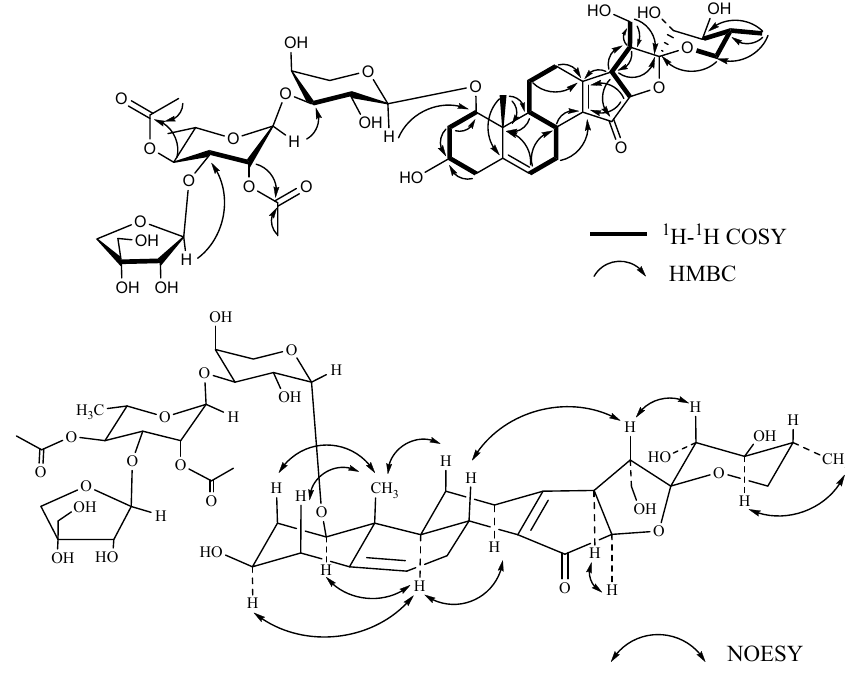
Figure 4. Key 1 H- 1 H COSY, HMBC, and NOESY correlations of compound 3 . Compound 4 , named Pamaiosides D, a white amorphous solid, was positive to Liebermann Burchard and Molisch chemical reactions. The pseudomolecular ion peak was measured in the HR-ESI-MS spectrum at m/z 993.3969 [M + Na] + (calculated for C 46 H 66 O 22 Na, 993.3943), corresponding to the molecular formula C 46 H 66 O 22 . Compared with 3 , only two distinctions, the position of one acetyl group and the sugar linkages, were detected (Tables 1–4). The acetyl group replaced at C-21, which was evidenced by the al- tered proton chemical shifts at δ H 3.46 (H-4 of Rha, ∆ δ C -1.49 ppm), δ Ha 4.19 (Ha-21, ∆ δ C + 0.45 ppm), and δ Hb 4.33 (Hb-21, ∆ δ C + 0.54 ppm). It was further acknowledged by the cross- peaks between δ H 2.08 (3H, s , C H 3 CO-)/ δ Ha 4.19, δ Hb 4.33 (H-21), and δ C 172.90 (CH 3 C O-) in the HMBC spectrum (Figure 5). In addition, the correlations for Api H-1 ( δ H 5.18) to Rha C-3 ( δ C 77.91), Rha H-1 ( δ H 5.28) to Ara C-4 ( δ C 75.62), and Ara H-1 ( δ H 4.30) to C-1 ( δ C 85.33) in the HMBC spectra clarified the linkages. Thus, compound 4 was characterized as 15- oxo-18-nor-(20 R ,22 R ,25 R )-spirost-5,13-diene-21- O -acetyl-1 β ,3 β ,21,23 α ,24 β -pentol-1- O - β - D -apiofuranosyl-(1 → 3)-2-acetyl- α - L -rhamnopyranosyl-(1 → 4)- a - L -arabinopyranoside.